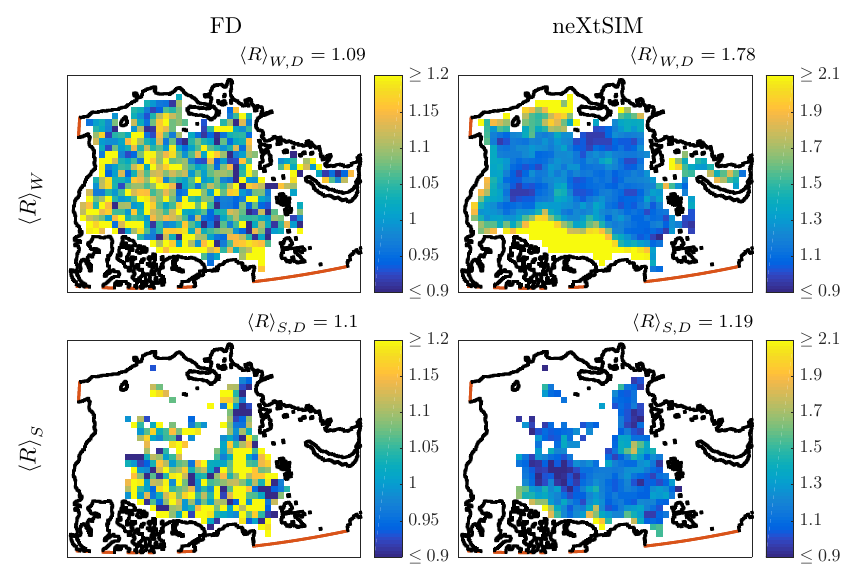
Figure 12. Means over the winter (top panels) and summer (bottom panels) of R(t) at t = 10 days. The values are represented by coloured squares centred on the starting points x 0 . The spatio-temporal mean values (i.e. domain averaged and seasonally averaged) are calculated for each model and displayed above each panels for